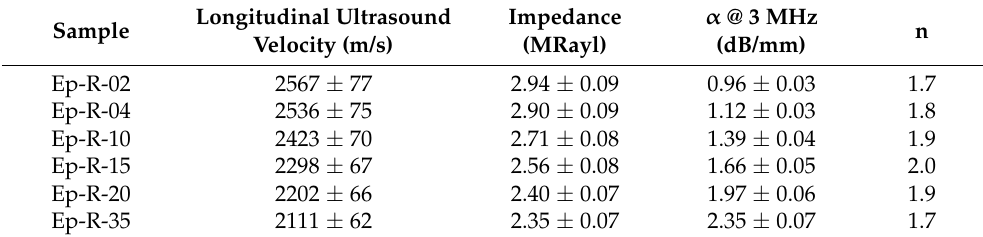
Table 9. Measured ultrasonic properties of the rubber-loaded epoxy